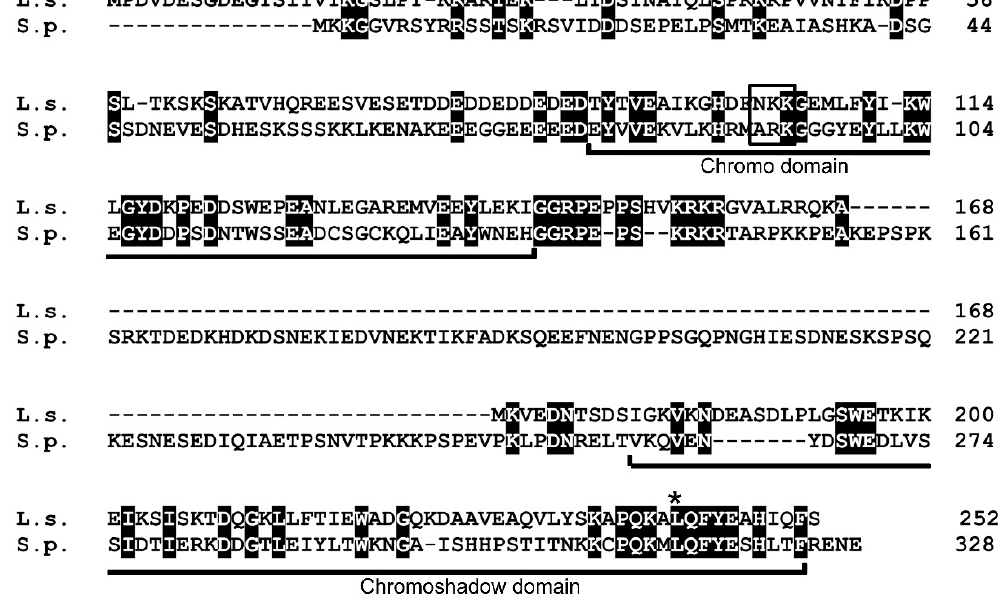
Figure 4. Amino acid sequence alignment of Lsw1 (L.s.) with Swi6 (S.p.). Black boxes indicate identical amino acid residues. The chromo domain (CD) and chromoshadow domain (CSD) regions are indicated. Open box, ARK-loop motif. Asterisk, leucine residue required for self-interaction of Swi6.